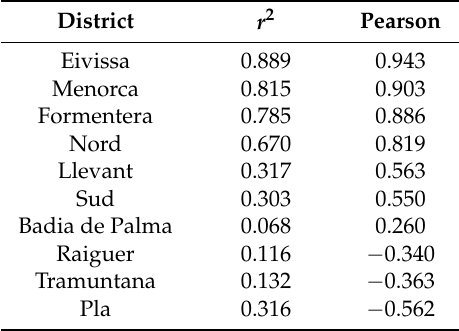
Table 3. Relationship between monthly variations in total emitted light and variations in the number of total workers affiliated per month per district.